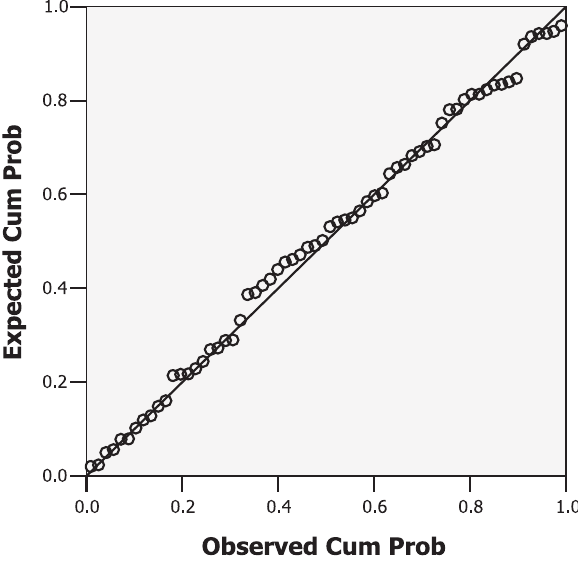
Fig. 2: Normal P-P Plot of Regression Standardized Residual, Dependent Variable: R m